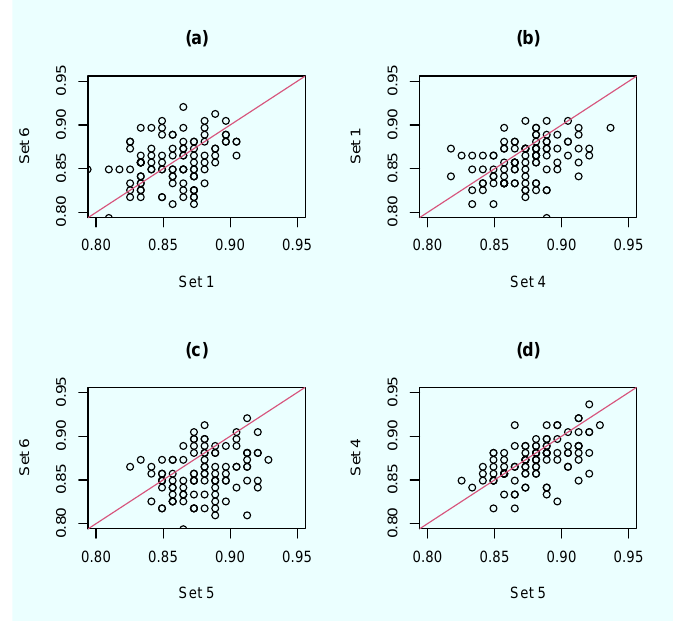
Figure 8. Scatter plots of the ACCs of different feature sets for test data based on 100 rounds: ( a ) Set 6 vs. Set 1, ( b ) Set 1 vs. Set 4, ( c ) Set 6 vs. Set 5, ( d ) Set 4 vs. Set 5, where the red line in each plot denotes the 45-degree